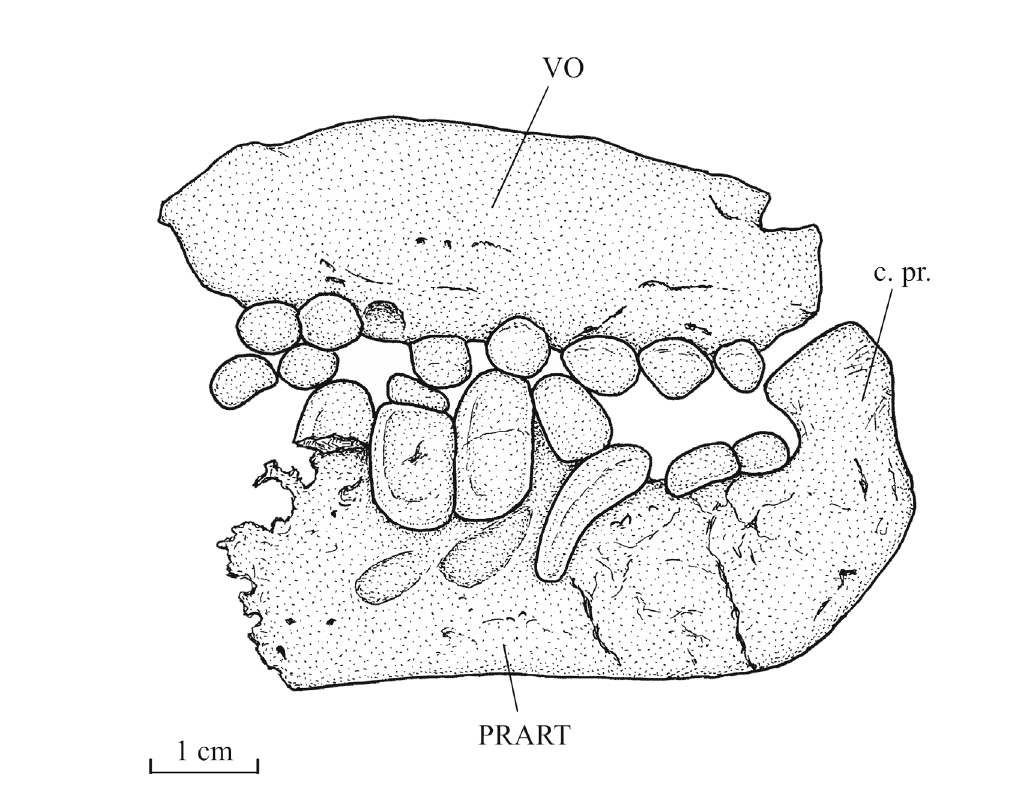
Fig. 18. Sigmapycnodus giganteus gen. et sp. nov., holotype, vomer and prearticular (CLC S-497a).